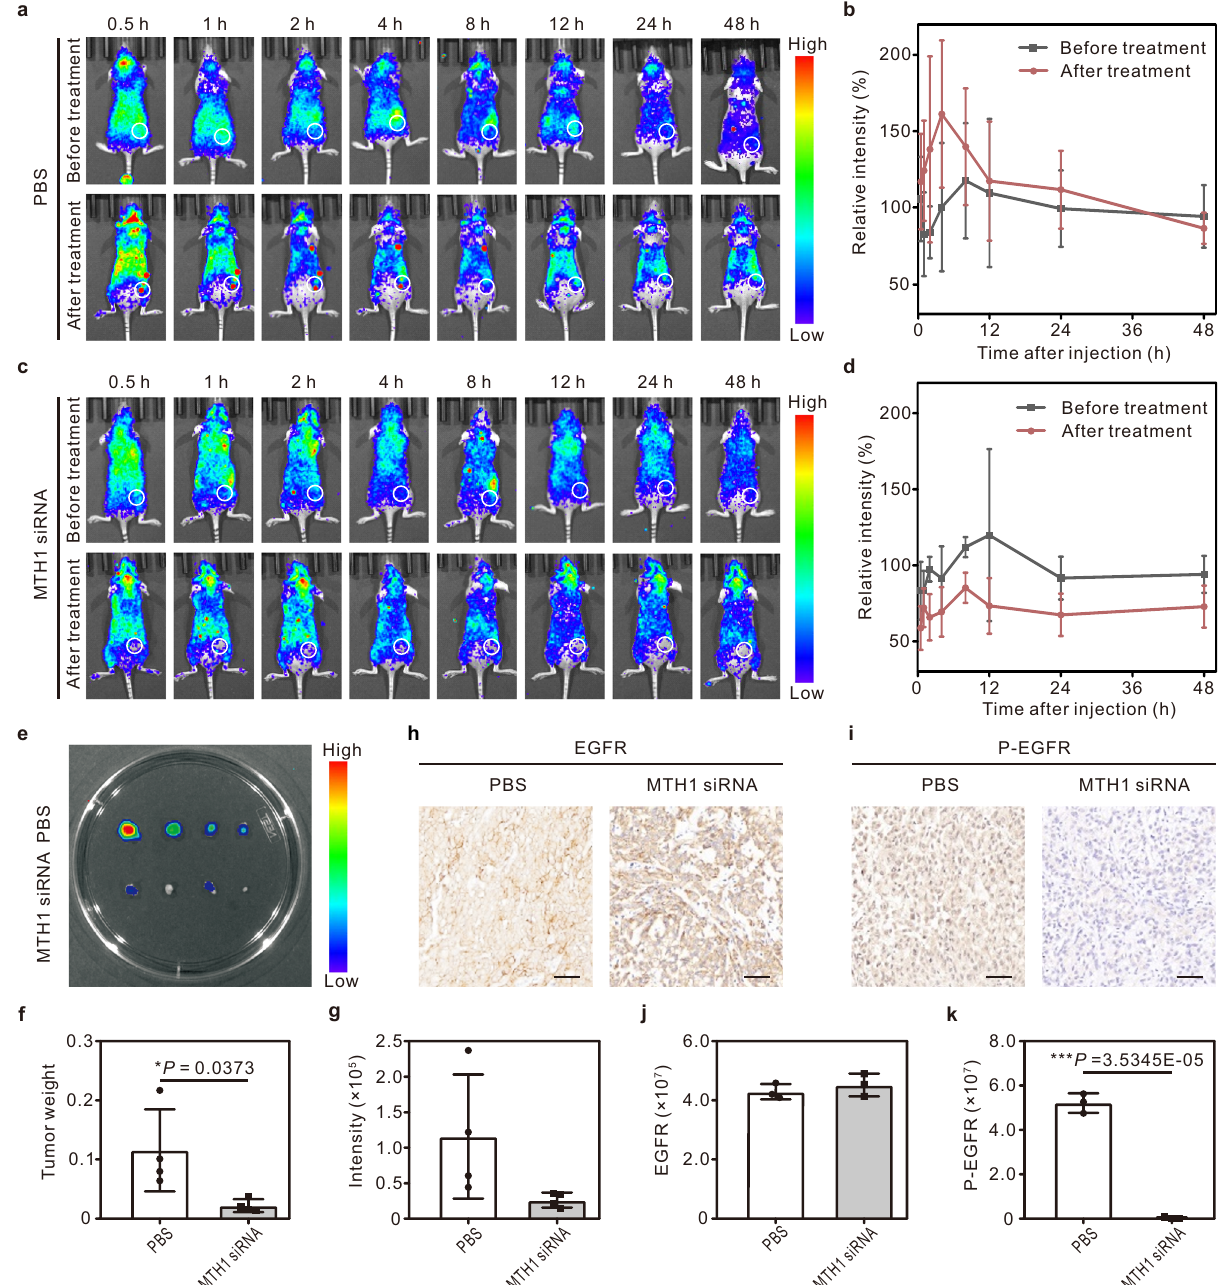
Fig. 6 EGFR signaling pathway-related electron transfer-triggered imaging in vivo during tumor treatment. Time-dependent whole-body fl uorescence images and corresponding quantitative data analysis of the tumor portion relative to the spinal symmetry region of A549 xenograft mice after intravenous injection of ETTE nanoprobe without ( a , b ) and with ( c , d ) treatment with MTH1 siRNA as a therapeutic agent for 14 days and before and after treatment. Color scale: 2.5 × 10 3 – 1.5 × 10 4 . Data presented as mean values± s.d., n = 3 mice. During the treatment, the afterglow images of mice treated with PBS or MTH1 siRNA were obtained at day 0 (Before treatment) and day 14 (After treatment). The afterglow imaging was performed after 1.0 s of white light excitation. The afterglow signal intensities are displayed as color maps. The white circles indicated the location of the tumor. The in vivo afterglow imaging was performed with triplicates. e A representative afterglow image of harvested tumor from the tumor-bearing mouse with ETTE nanoprobes, showing that the afterglow signal mostly appeared in large tumors. Color scale: 1.0 × 10 4 – 5.0 × 10 4 . f The average tumor weight of each group at the experimental endpoint. Tumors were resected after the initial treatment. Data presented as mean values ± s.d., n = 4 mice. g Quantitative analysis of afterglow intensity in the tumor site. Data presented as mean values ± s.d., n = 4 mice. h , i IHC analysis of primary tumor sections. EGFR ( h ) and P-EGFR ( i ) in the tumor sections of each group were observed by IHC analysis. Scale bar: 50 μ m. Quantitative analysis of EGFR ( j ) and P-EGFR ( k ) in tumor site observed by